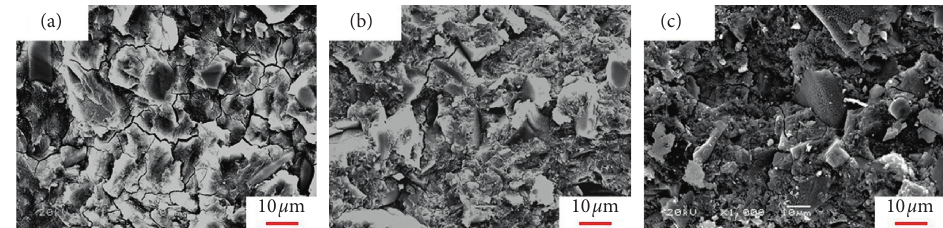
Figure 9: SEM micrographs of AAS at 28d curing time. (a) A0S10-5M; (b) A4S6-5M; and (c) A8S2-5M.